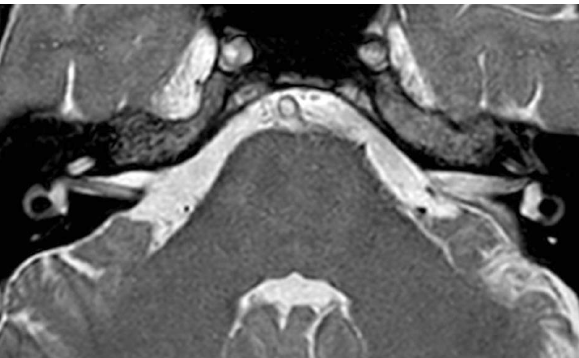
Fig. 4. Postoperative